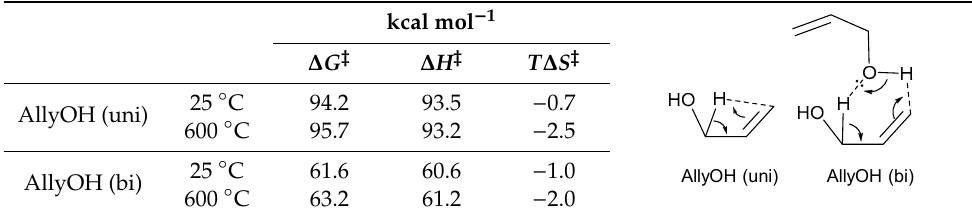
Figure 14. Possible heterolytic dehydration pathways for glycerol (Gly). The values next to the arrows represent the activation energies (kcal mol − 1 ), as calculated at the MP4(SDQ)//DFT(M06-2X) level. ACR, acrolein; HA, hydroxyacetone; AA, acetaldehyde; FA, formaldehyde; uni, unimolecular mechanism; and bi, bimolecular mechanism.